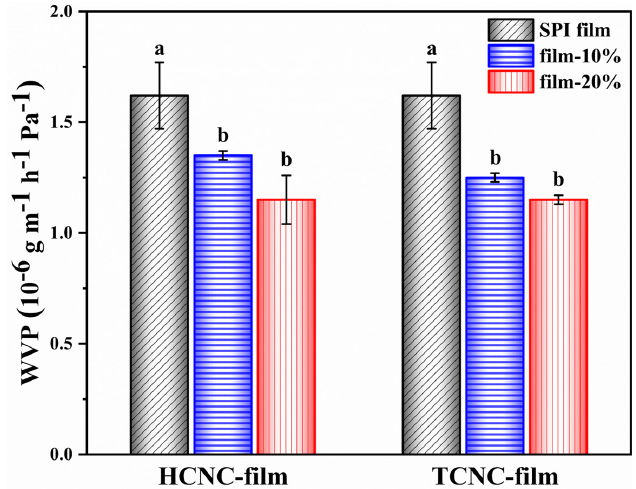
Figure 6. Water vapor permeability (WVP) of SPI and SPI/CNC films. Different letters on the tops of the columns indicate significant difference ( p < 0.05) in terms of CNC content.